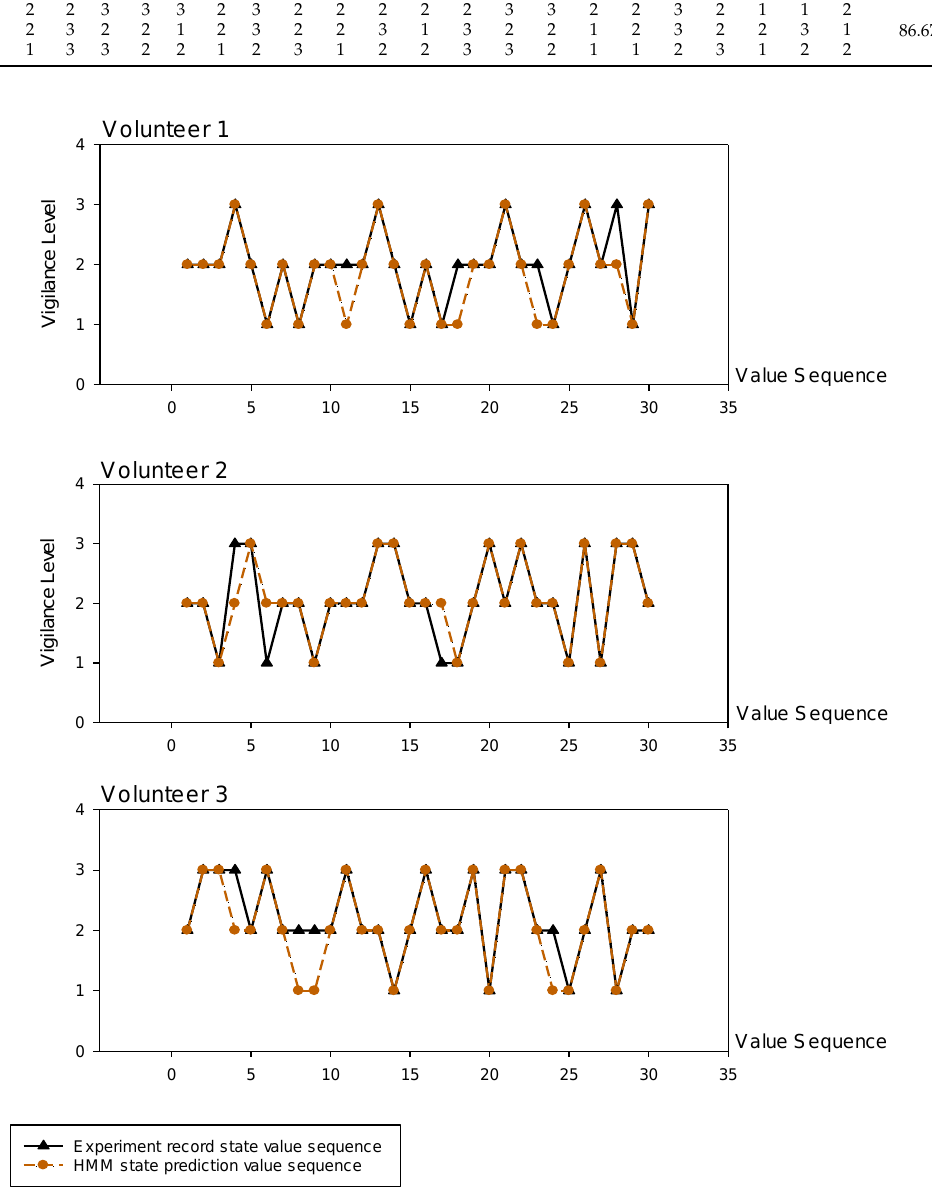
Figure 9. Validation results for vigilance assessment using hidden Markov model.